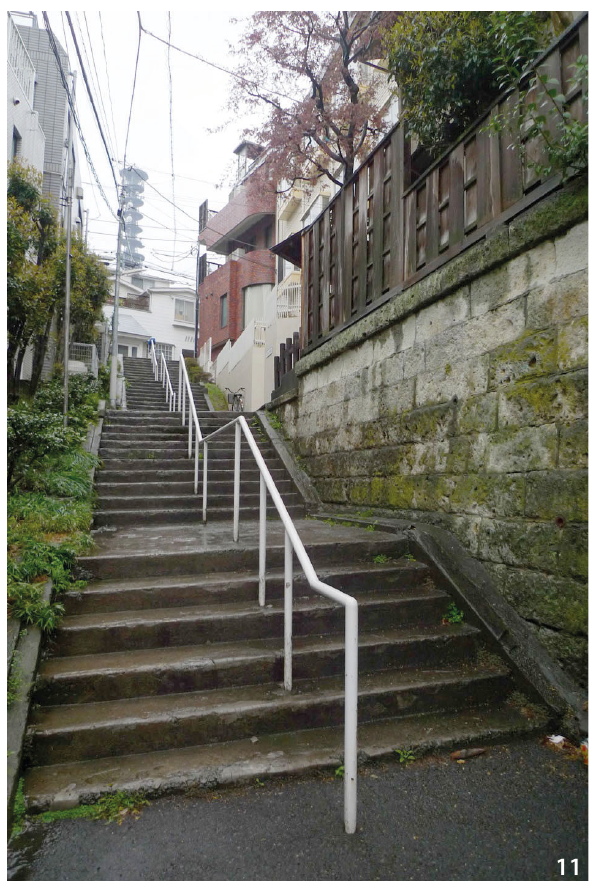
Figure 11 Yotsuya Araki-cho, with its uneven topography, a sacred place for the Tokyo Suribachi Gakkai (Mortar Society) (Source: the au-